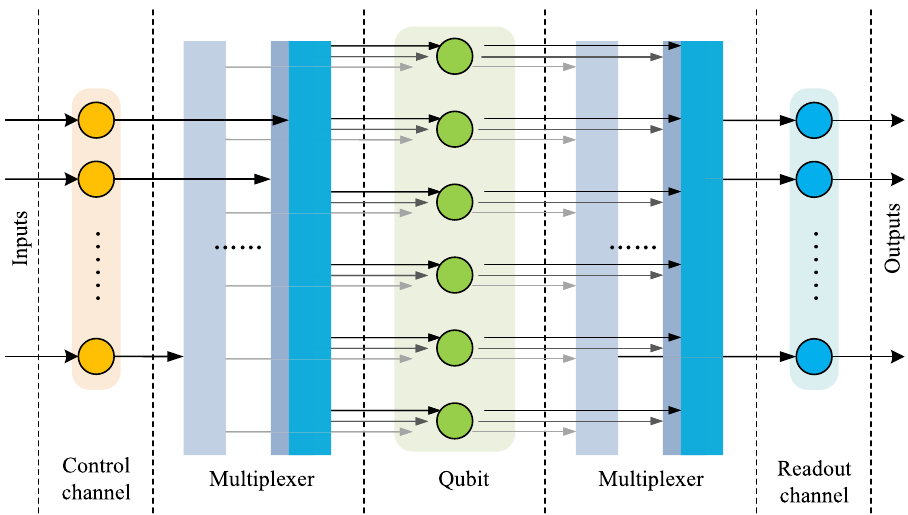
Figure 1. Centralized control and multiple readout system for superconducting quantum computing. There are M control channels, N qubits and K readout channels, where 2 ≤ M ≤ N and 1 ≤ K ≤ N